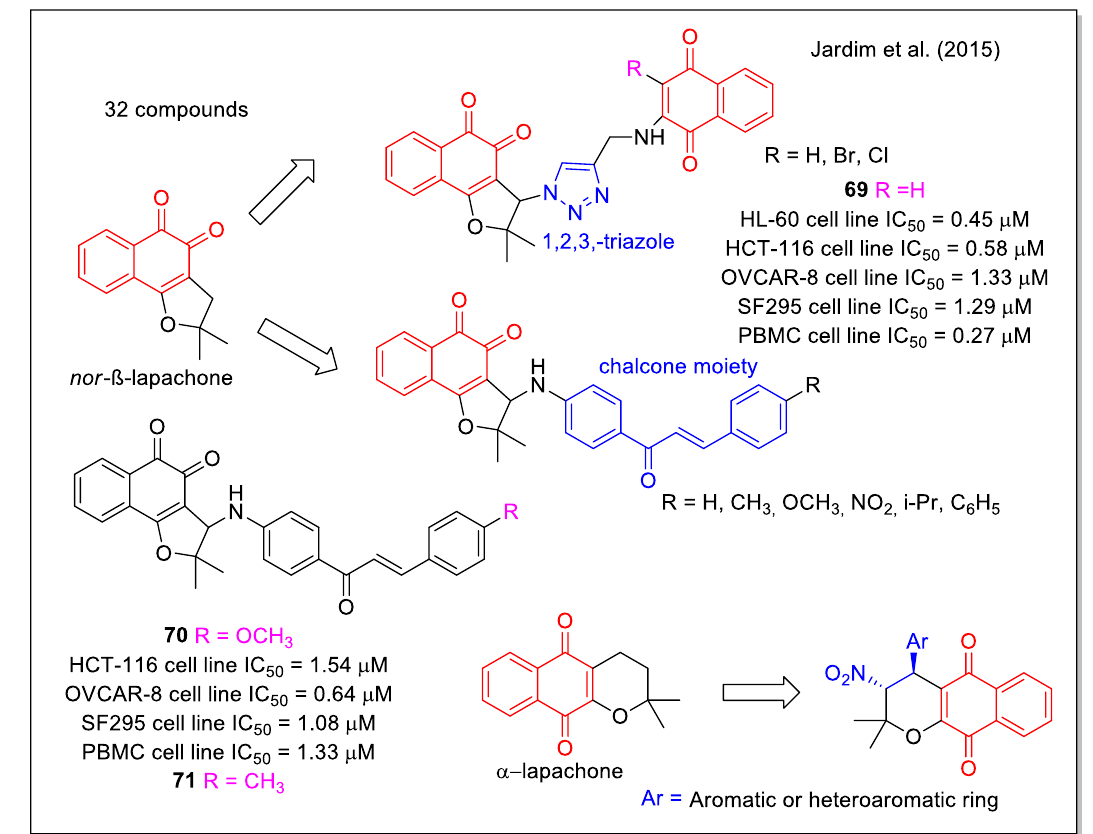
Figure 25. Lapachone hybrids with 1,2,3-triazole or chalchone, or nitro group units as reported by Jardim et al. [67].